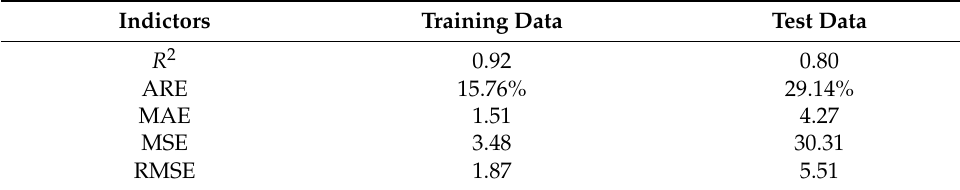
Table 4. Statistical indictors for both training and test data.